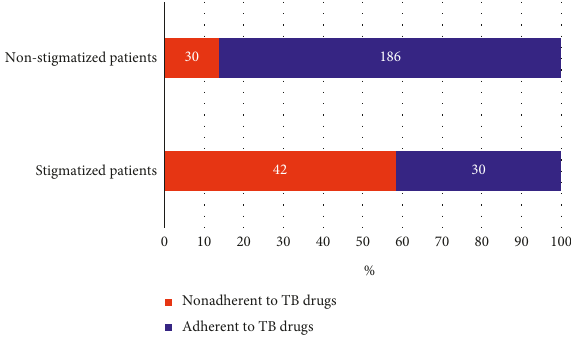
Figure 2: The proportion of TB patients who perceived stigmatized. Figure